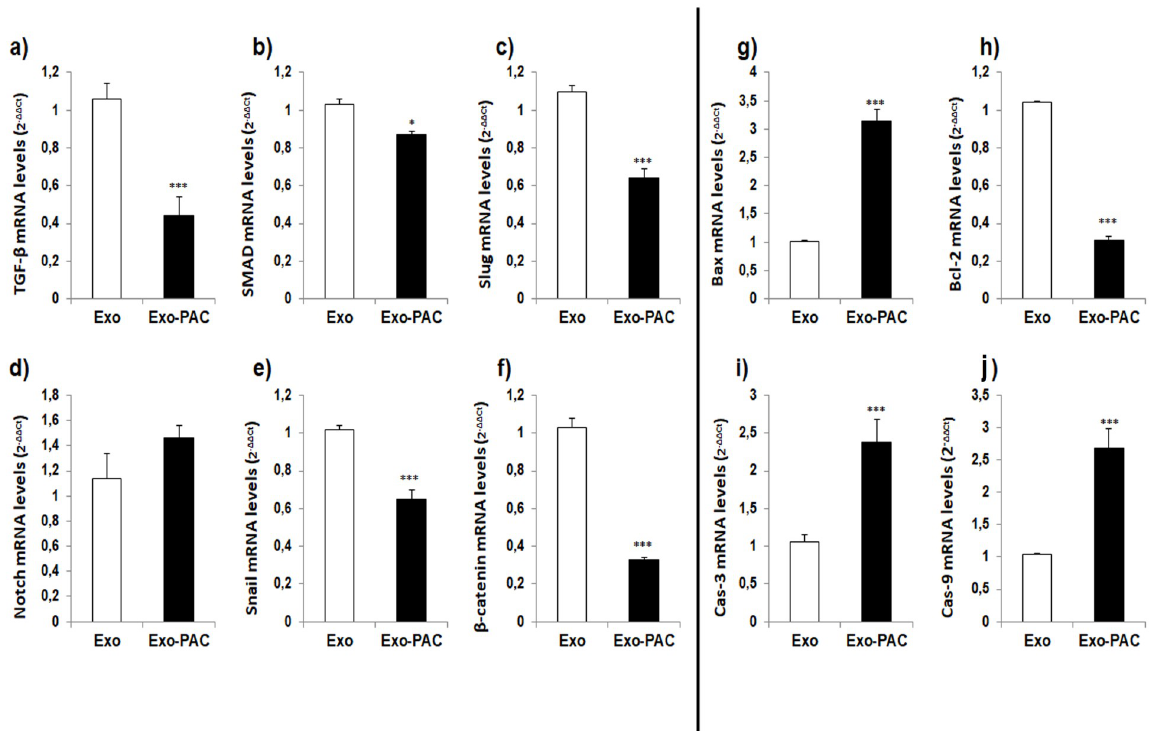
Fig 5. Graphs of mRNA levels of EMT and apoptosis-related